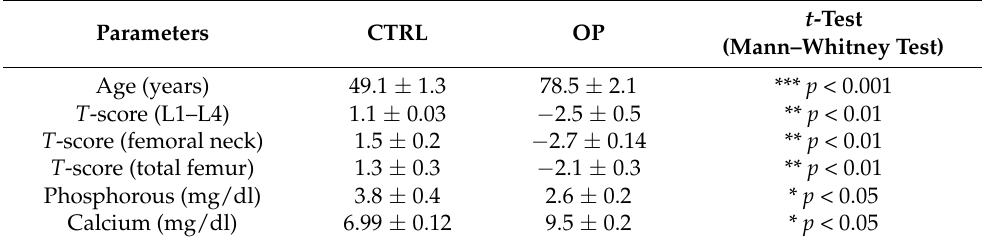
Table 1. Clinical data of CTRL and OP